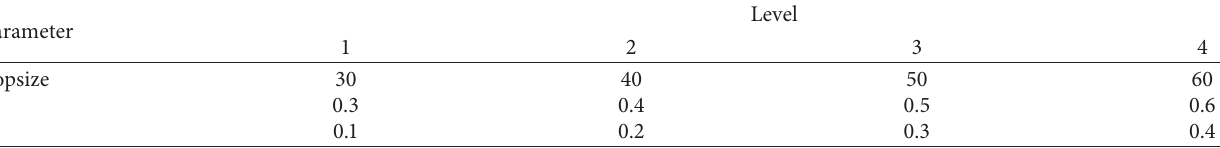
Table 1: Parameter level.